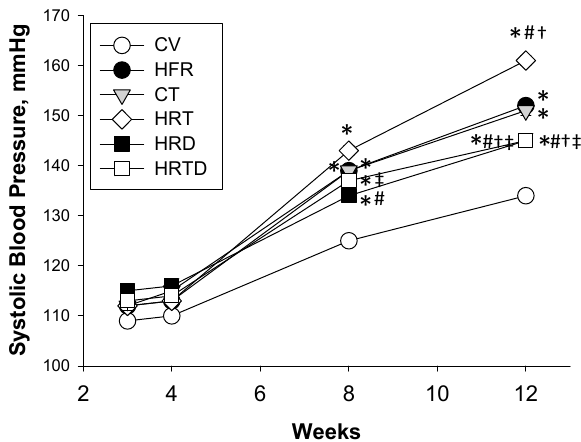
Figure 2. Effects of high-fructose intake, 2,3,7,8-tetrachlorodibenzo-p-dioxin (TCDD) exposure, and 3,3-dimethyl-1-butanol (DMB) on systolic blood pressures in offspring from 3 to 12 weeks of age. CV